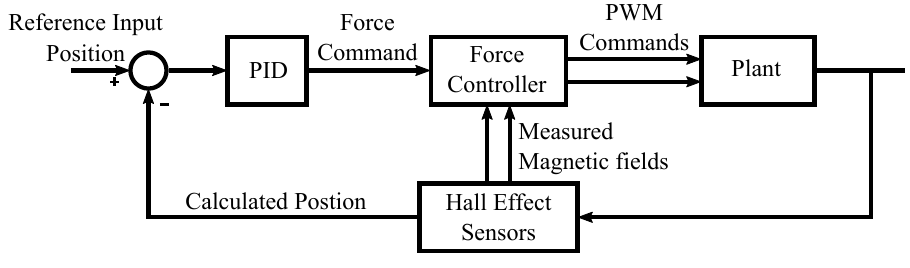
Figure 7. Control